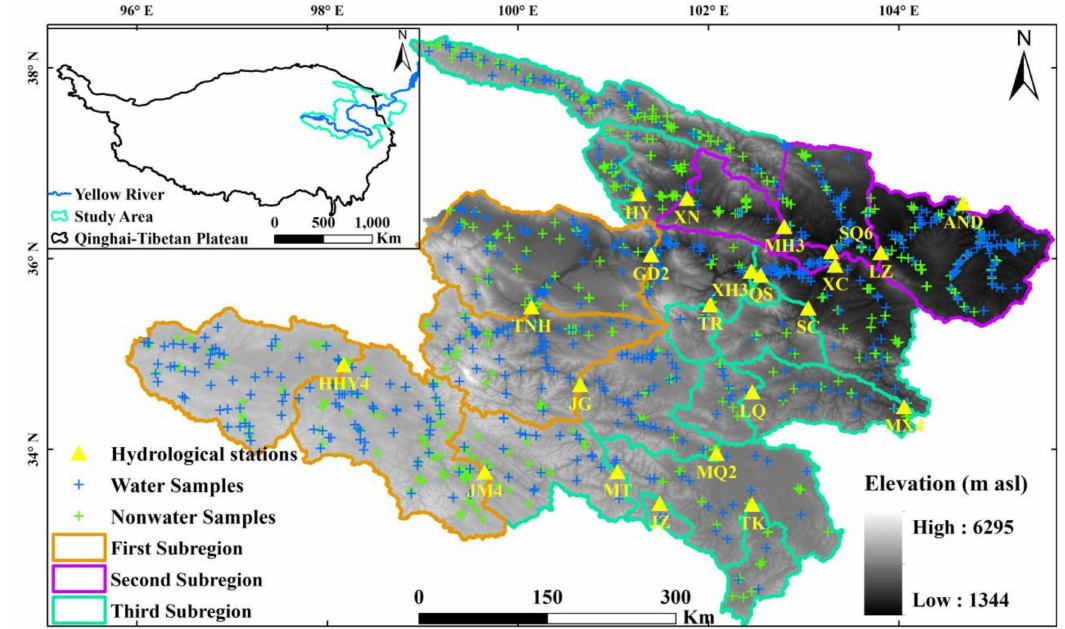
Figure 2. Geographical location of the study area and distribution of the hydrological stations and training samples. Subregions are marked as “First”, “Second”, and “Third”. Hydrological stations are marked with yellow triangles. Water samples are marked with blue crosses, and nonwater samples are marked with green